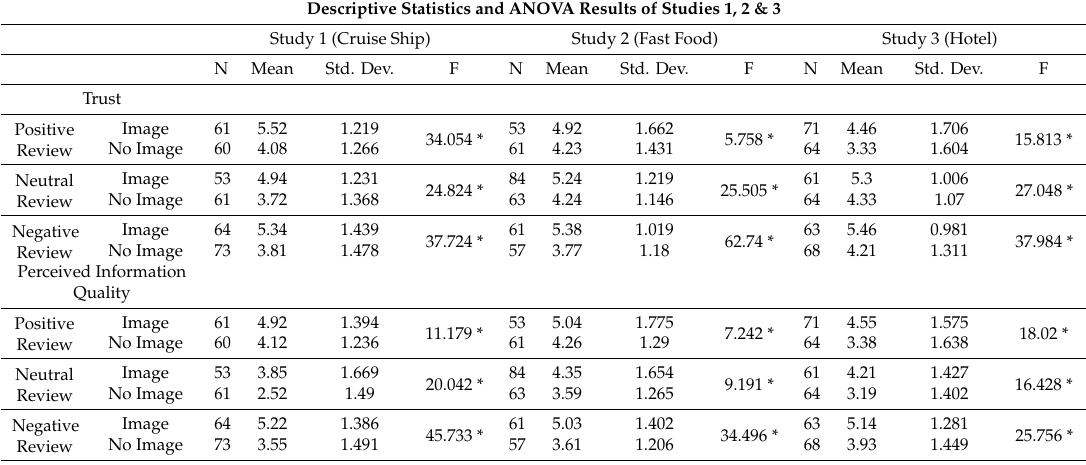
Table 1. Presents the results of ANOVAs run on those data for all three studies (i.e., cruise ship, fast food and hotel). The outcomes for the studies are consistent in that adding an image increases both trust and perceived information quality. It is interesting to note that, typically, the largest increase of trust and information quality were when images were added to negative reviews (i.e., as opposed to neutral or positive reviews). Therefore, the data support both H1 and H1a in that adding images to reviews (for positive, neutral and negative reviews, increases trust and perceived information quality).